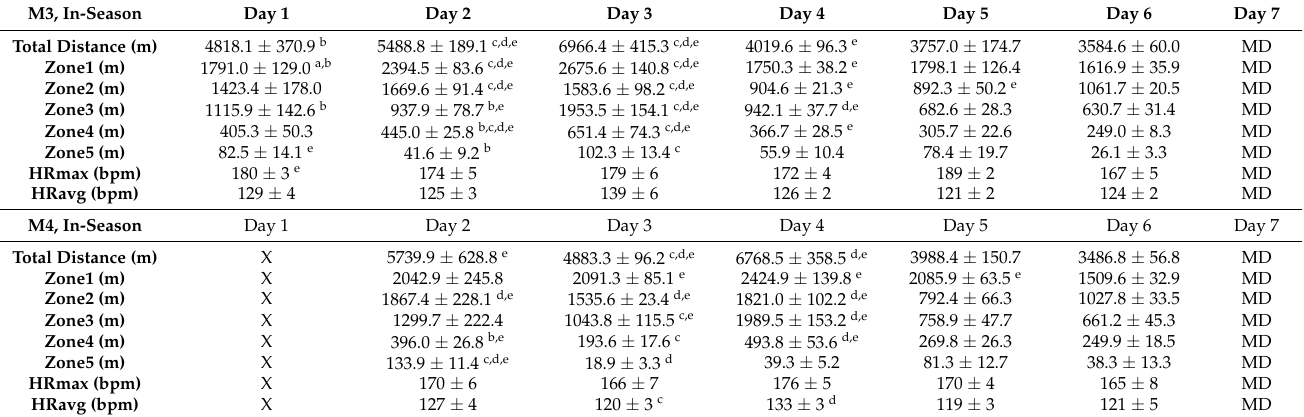
Table 4. Distances covered at different speed thresholds and heart rate variables (representative of squad average data) during the 7-day period in